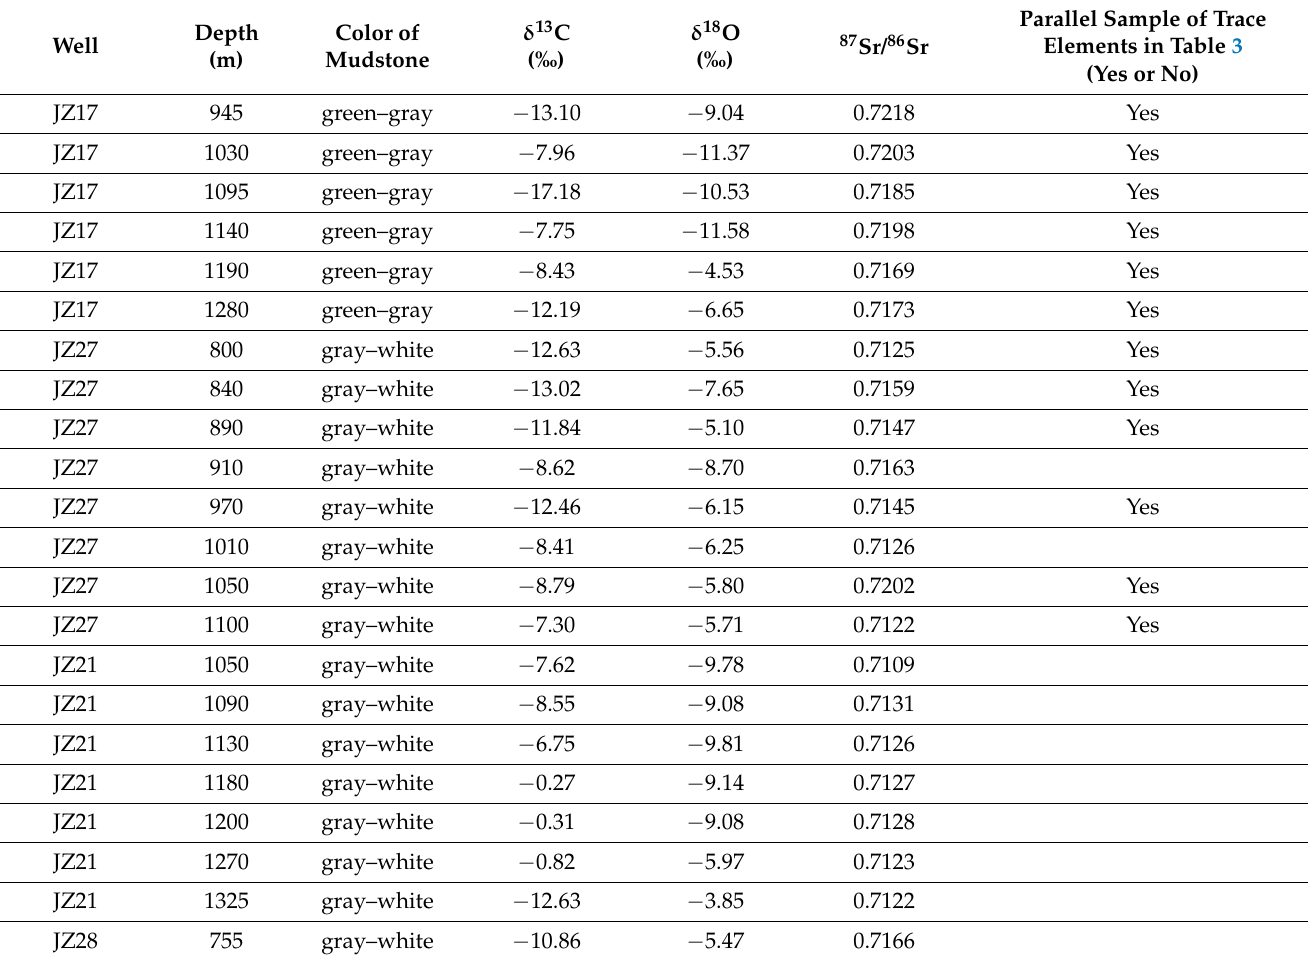
Table 4. Data of carbon, oxygen, and strontium isotopes in the mudstones of the Guantao